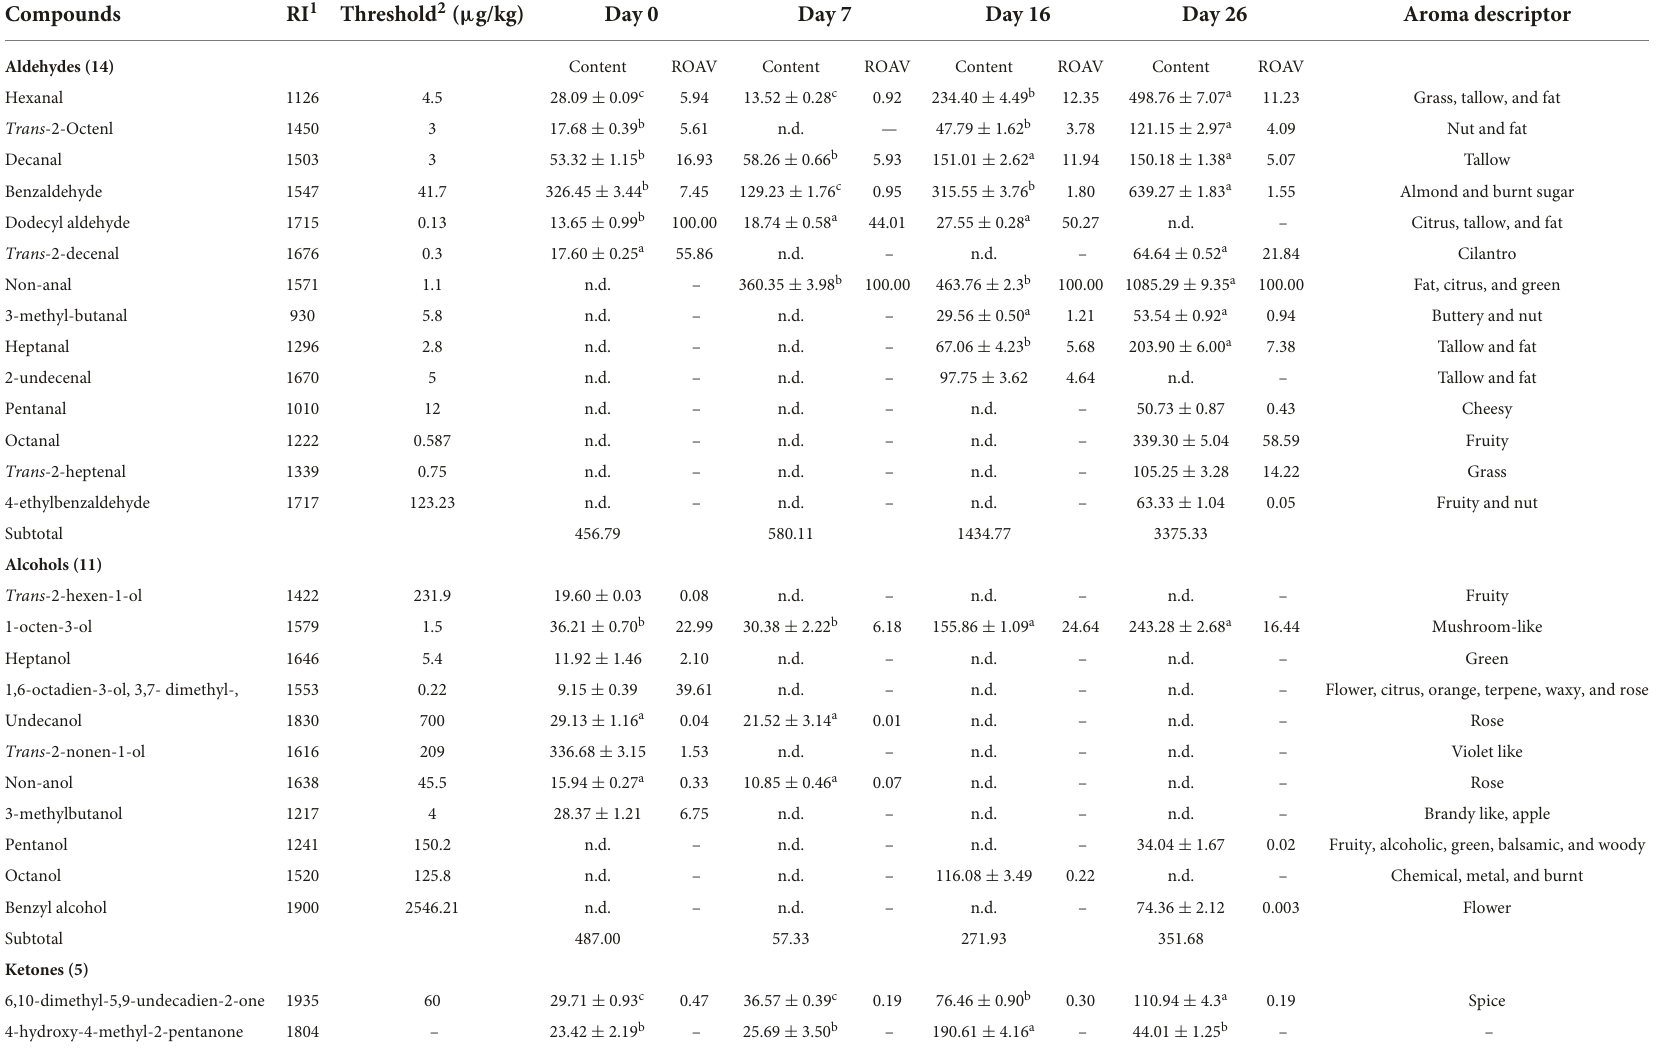
TABLE 3 Contents ( µ g/kg) of volatile compounds of fermented mutton sausage during natural ripening (means ± standard